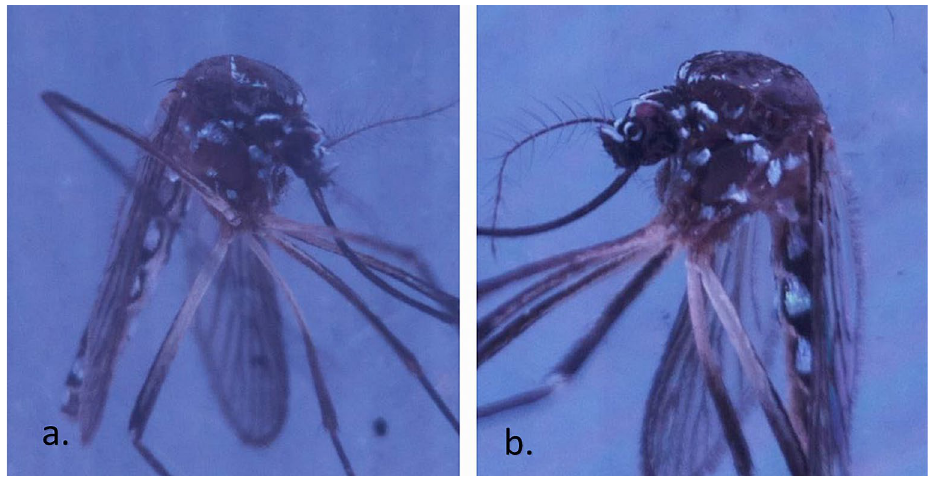
Figure 4. Sample of 10-day-old ( a ) and 16-day-old ( b ) Aedes aegypti ,